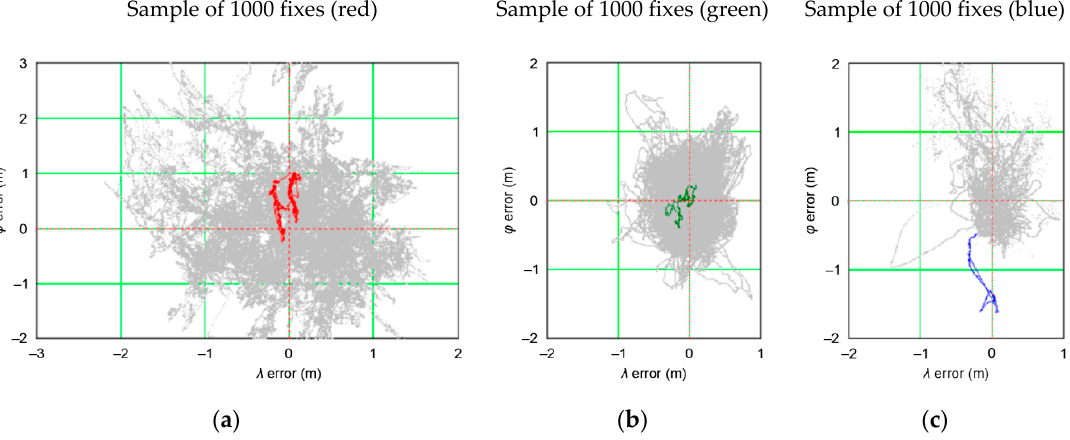
Figure 2. Examples of the Position Random Walk (PRW) for ( a ) Global Positioning System (GPS); ( b ) Differential Global Positioning System (DGPS); ( c ) EGNOS.